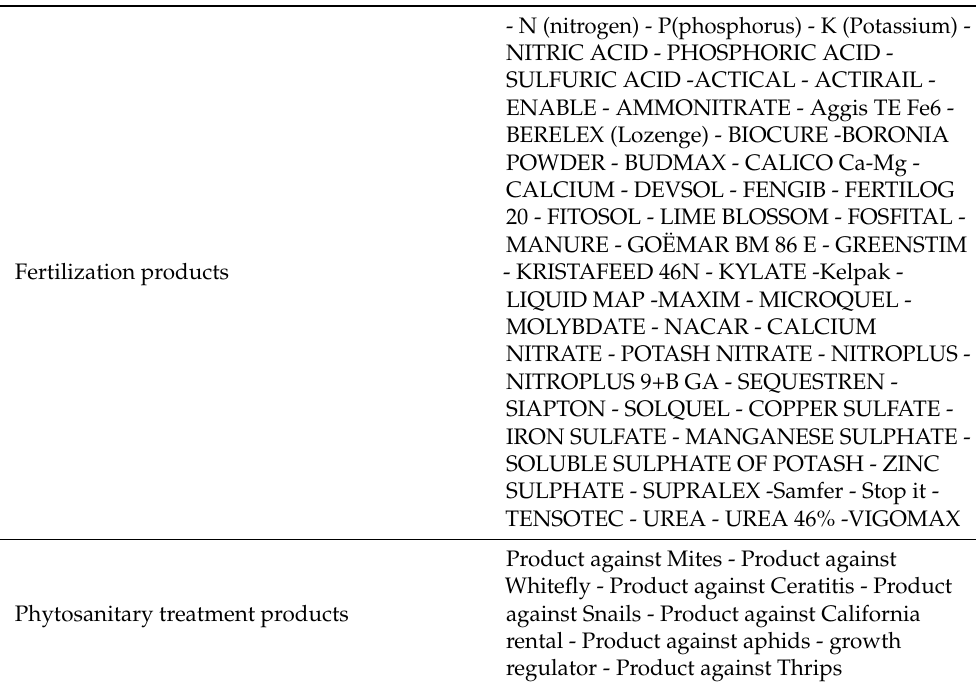
Table 1. Fertilization and phytosanitary treatment